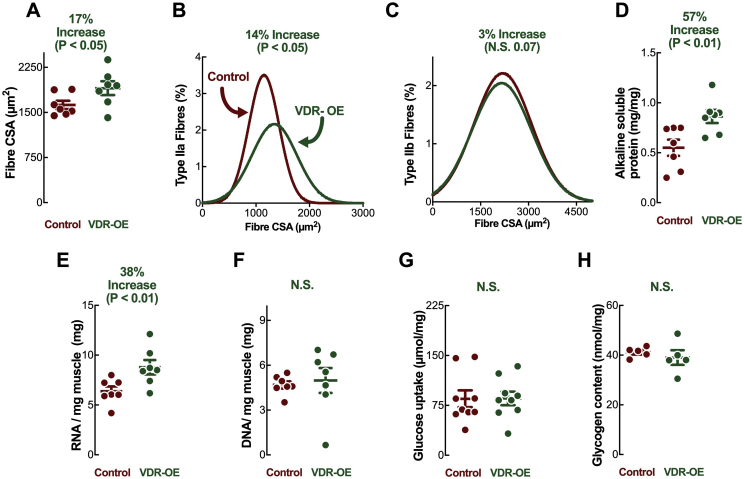
In vivo VDR-OE results in muscle fibre hypertrophy. (A) All fibre CSA analysis, (B) Type IIa and (C) IIb fibre CSA distribution. Three random fields of view were measured per section in both L and R TA muscles in each animal (n = 7), with CSA measured for all intact fibres. (D) Alkaline soluble protein measures, (E) RNA and (F) DNA quantification per mg of dried muscle (n = 7). (G) Glucose uptake measured by 3H—2-deoxyglucose tracer uptake (n = 9). (H) Muscle glycogen content (n = 5). Data are mean ± SEM. Significance by paired t-test.